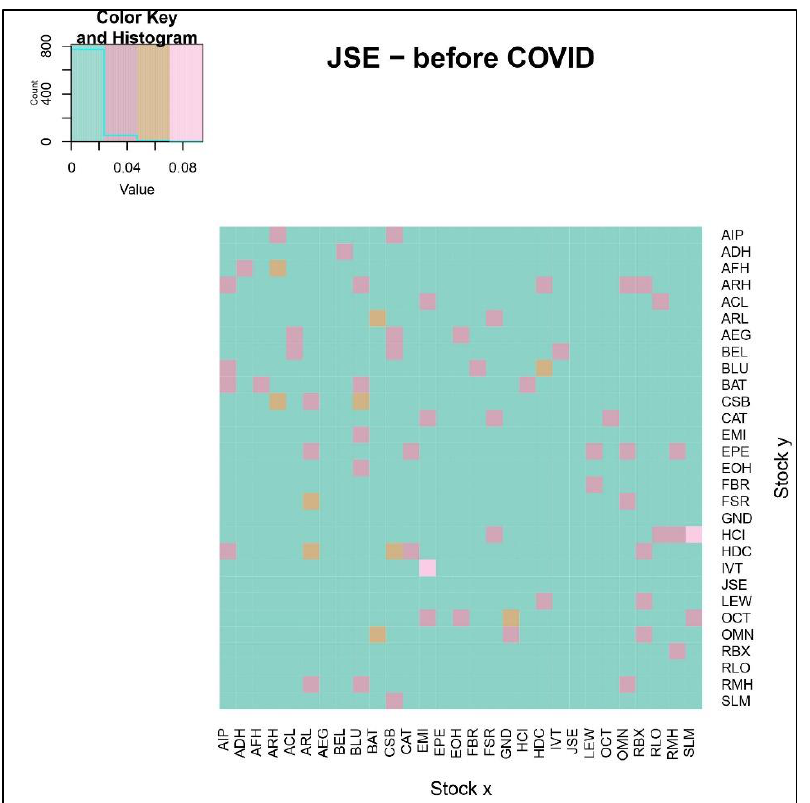
Figure 9. The information flow (effective transfer entropy) from stock y to stock x, for the top companies (by market capitalization) in the JSE market, before the COVID-19 outbreak